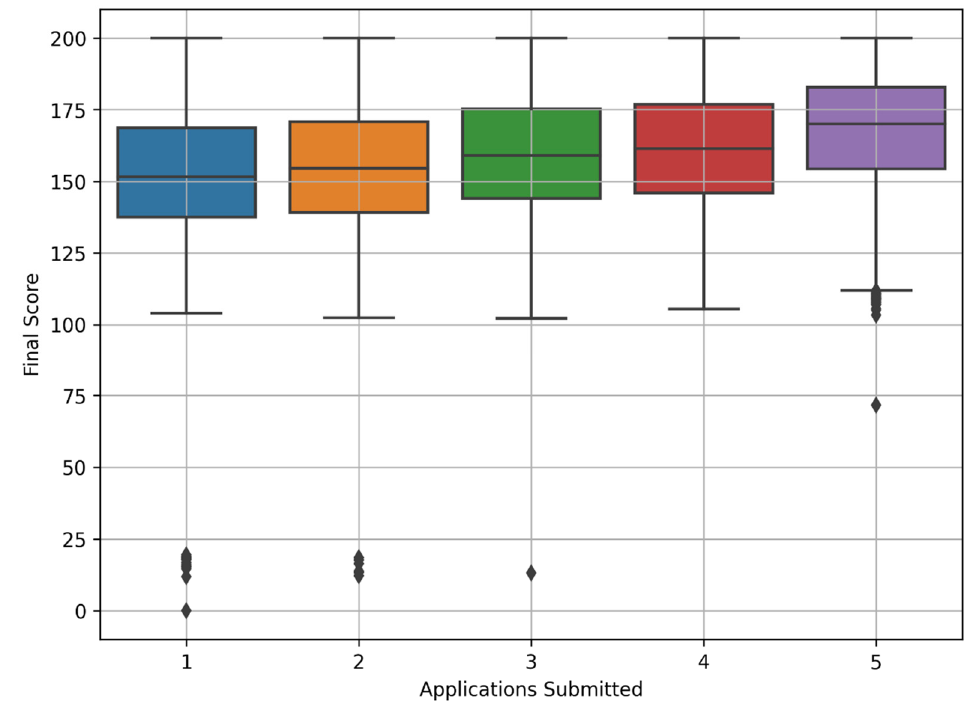
Figure 9. Final score box plot of admitted applicants by their applications submitted count.